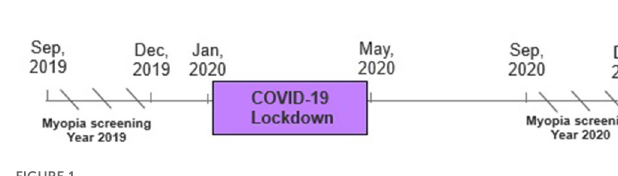
FIGURE1 Timeline of COVID-19 lockdown and myopia